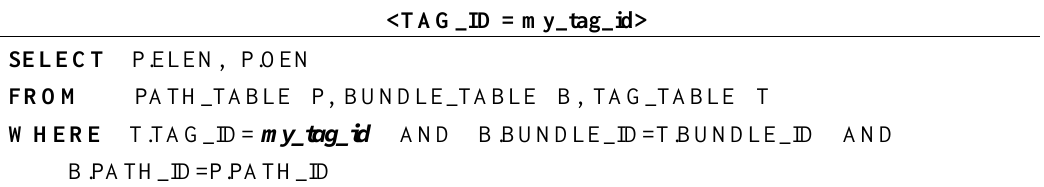
Table 6. SQL statements of